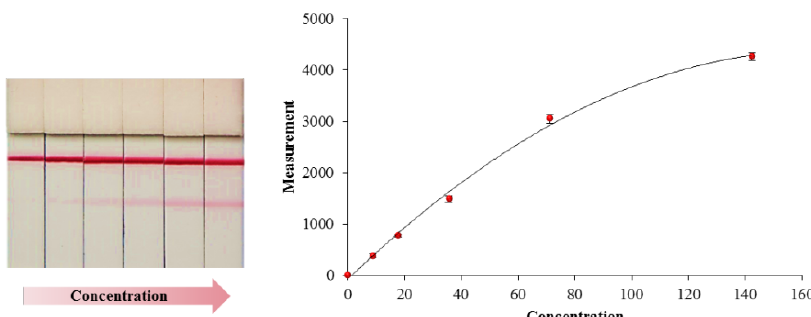
Figure 3. An example of a standard curve employed to quantify the concentration of an analyte in the lateral-flow immunoassay (LFIA) (Adapted from [23]).